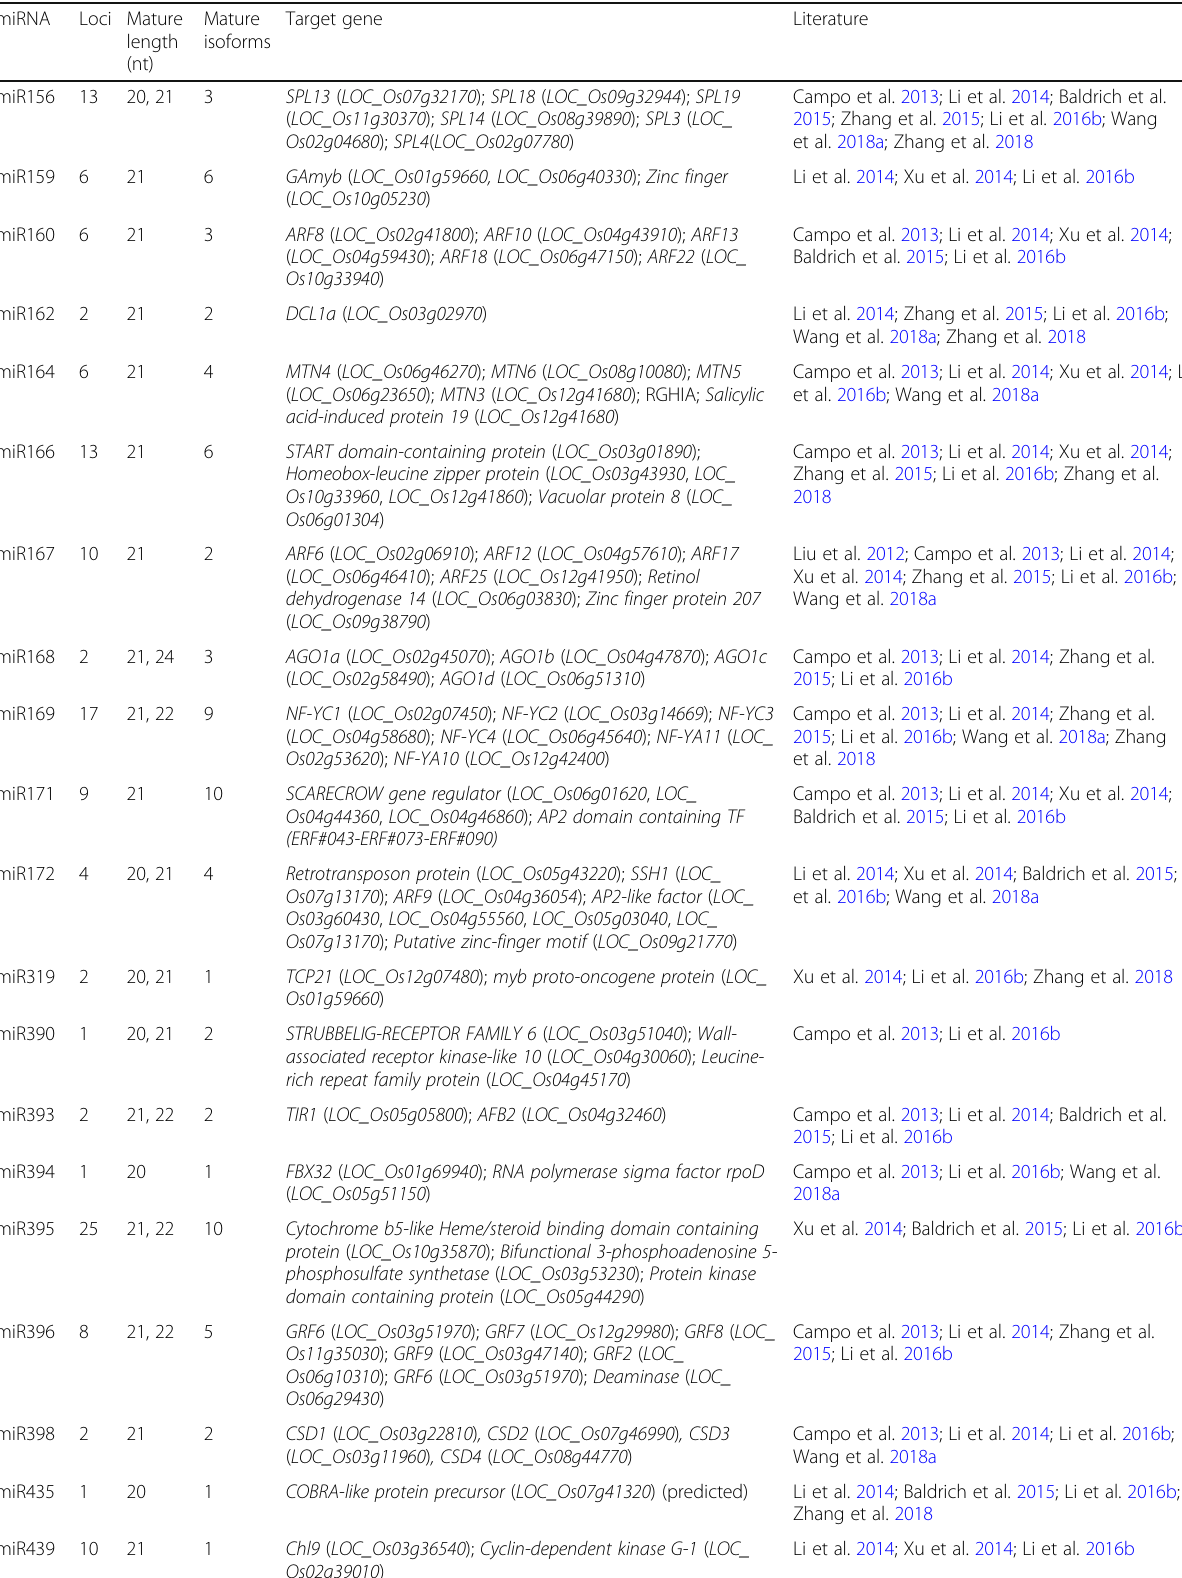
Table 1 miRNAs responsive to Magnaporthe oryzae or its elicitors a miRNA Loci Mature